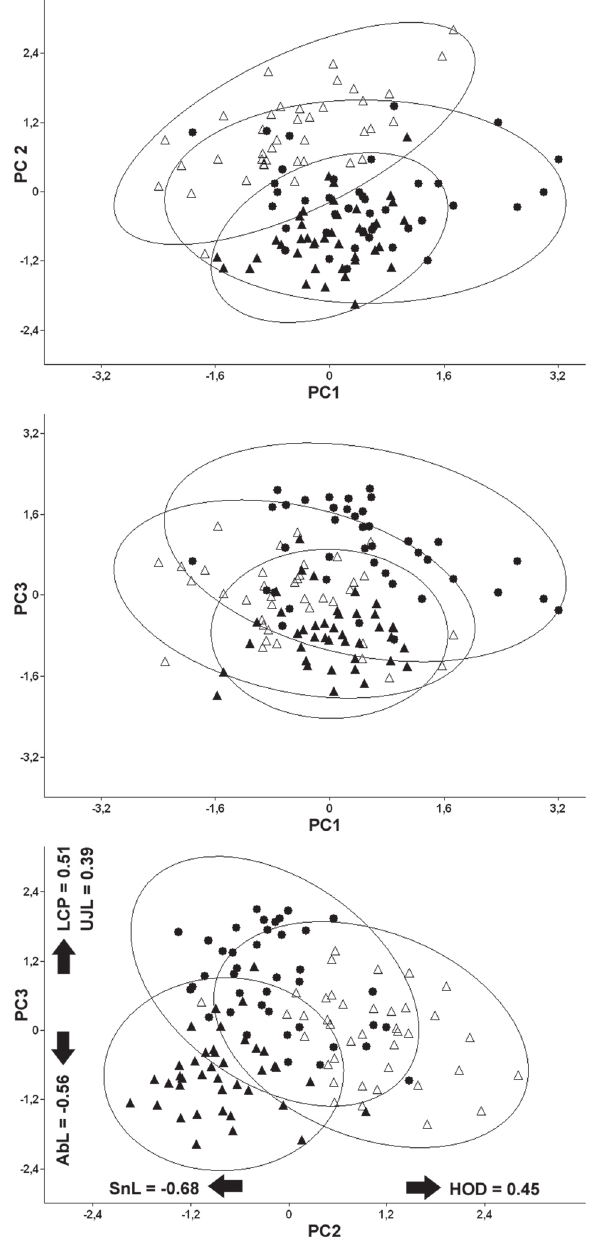
Fig. 9. Principal Component Analysis (PCA) of Macropsobrycon uruguayanae from three different basins: laguna dos Patos basin (dots), rio Uruguay basin (filled triangles), and rio Negro basin (empty triangles); based on the 18 morphometric variables listed in Table 1, except dorsal-fin length. Ellipses correspond to 95% confidence ellipses. The largest loadings are indicated on the second and third principal components (PC2, PC3), where AbL = anal-fin base length; HOD = horizontal orbit diameter; LCP = length of caudal-peduncle; SnL = snout length; UJL = upper jaw